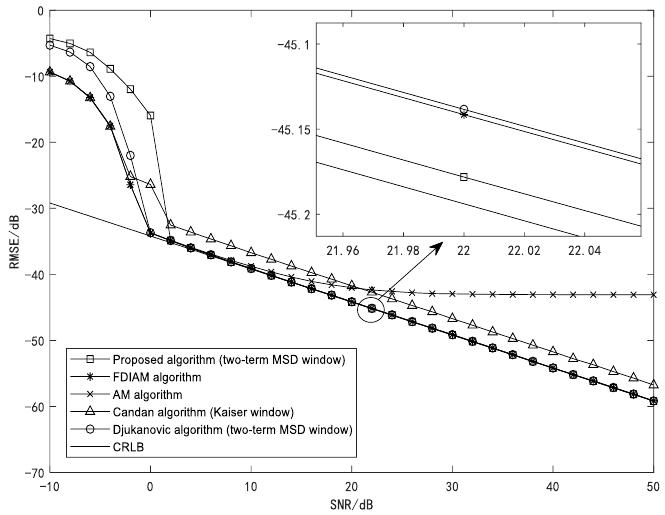
= 128, φ = π /8, and f